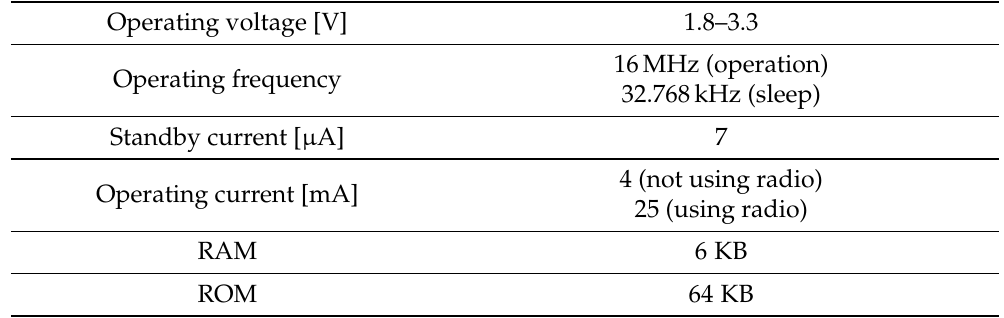
Table 2. The specification of the Lazurite 920J.